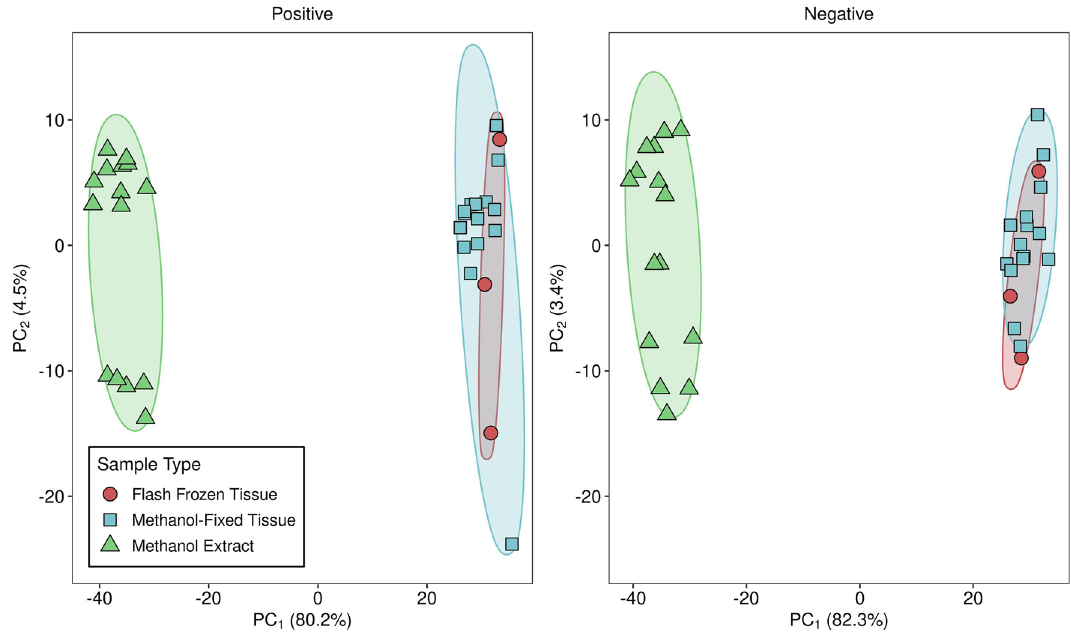
Figure 2. 2-dimensional principal component plots stratified by positive and negative ion mode and by sample type (flash frozen tissue, methanol-fixed tissue, and methanol extract). Percentage of variability explained by each component is shown in parentheses on axis labels. PC 1 first principal component, PC 2 second principal